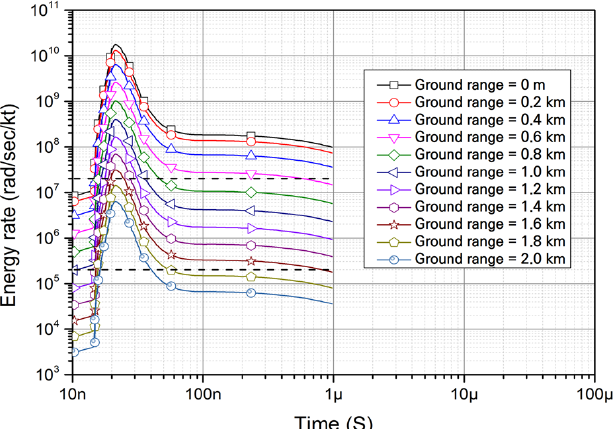
Figure 4. Simulation result of energy rate (rad/sec/kt) accumulated in Si sensor according to distance and time by prompt gamma rays (HOB is 503 m [18] and the sensor is located 1 m above the ground).